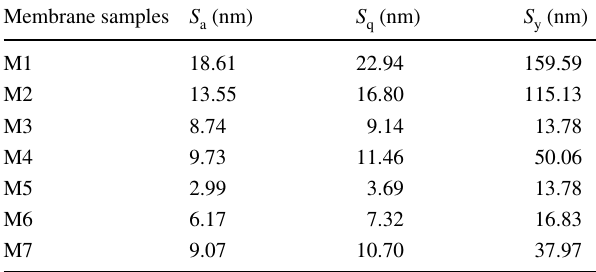
Table 3 Surface roughness parameters of the prepared membranes Membrane samples S a (nm)